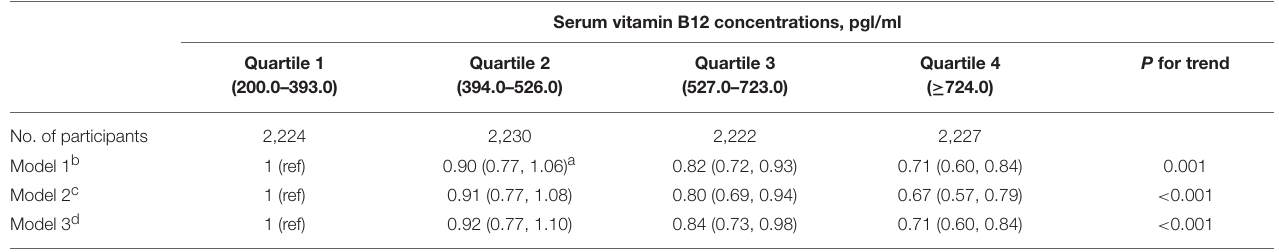
TABLE 3 | Sensitivity analysis for the association of serum vitamin B12 concentrations with obesity in 8,903 US adults with normal vitamin B12 concentrations. Serum vitamin B12 concentrations,